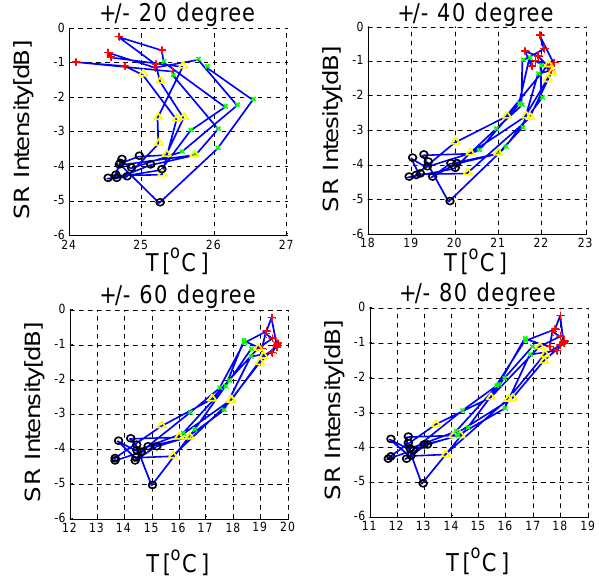
Fig. 5. Lissajous figures of the Schumann resonance intensity ver- sus global temperature. Green markers denote spring, red is sum- mer, yellow is autumn, and black shows Fig.5. Lissajous figures of the Schumann resonance intensity versus global temperature. Green markers denote the spring, red is the summer, yellow is autumn, and black shows the winter.